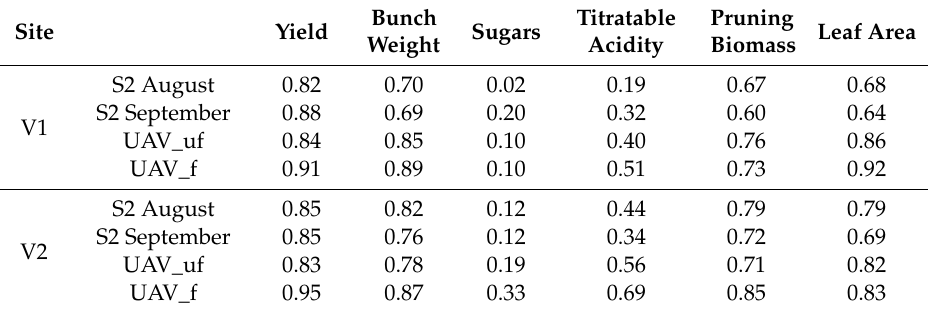
Table 4. Correlation coe ffi cients (R 2 ) between remote and ground